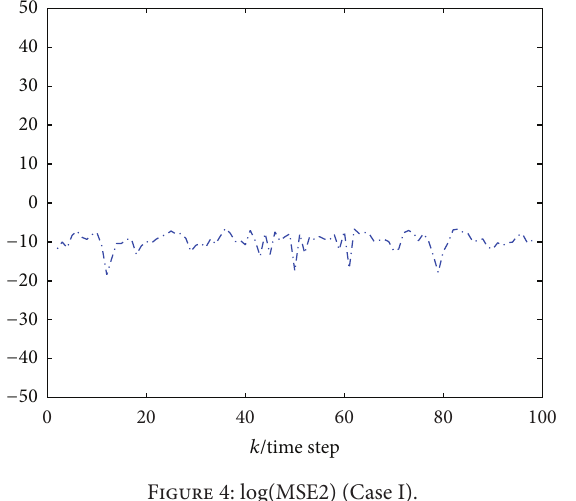
Figure 4: log(MSE2) (Case I).